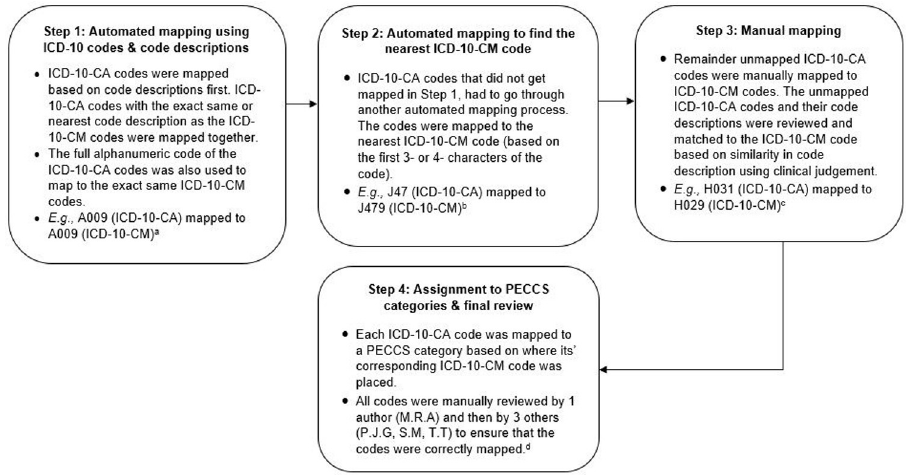
Fig 2. Diagram outlining the step-by-step procedure used to translate PECCS from ICD-10-CM to ICD-10-CA for use in Canada. a The ICD-10 code description for A009 in ICD-10-CA and ICD-10-CM is ‘Cholera , unspecified’ . b